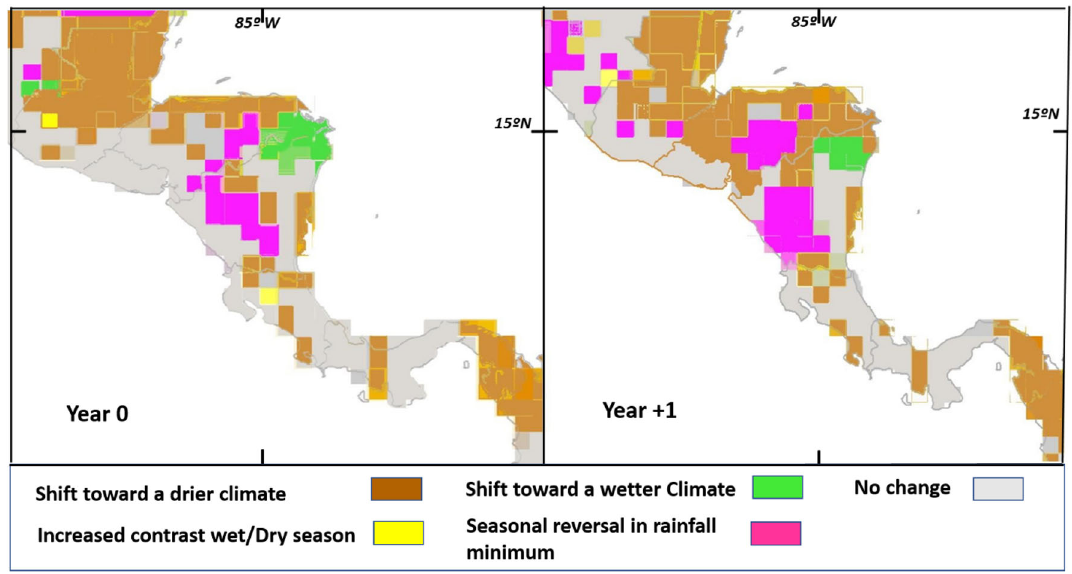
Fig. 9 Major shifts of El Nin˜o climate regime for Central America according to our Ko¨ppen–Geiger